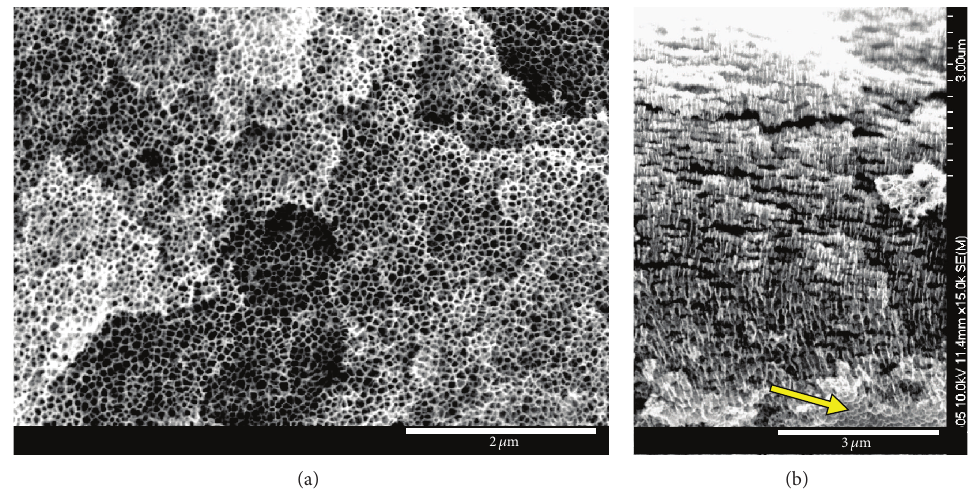
Figure 2: FE-SEM top-view (a) and cross-sectional view (b) images of nanoporous oxide layer obtained during one-step anodization of high-purity Sn in 0.3 M oxalic acid at 9 V. Duration of the process was 1800 s. The arrow in (b) indicates the bottom of the oxide layer.